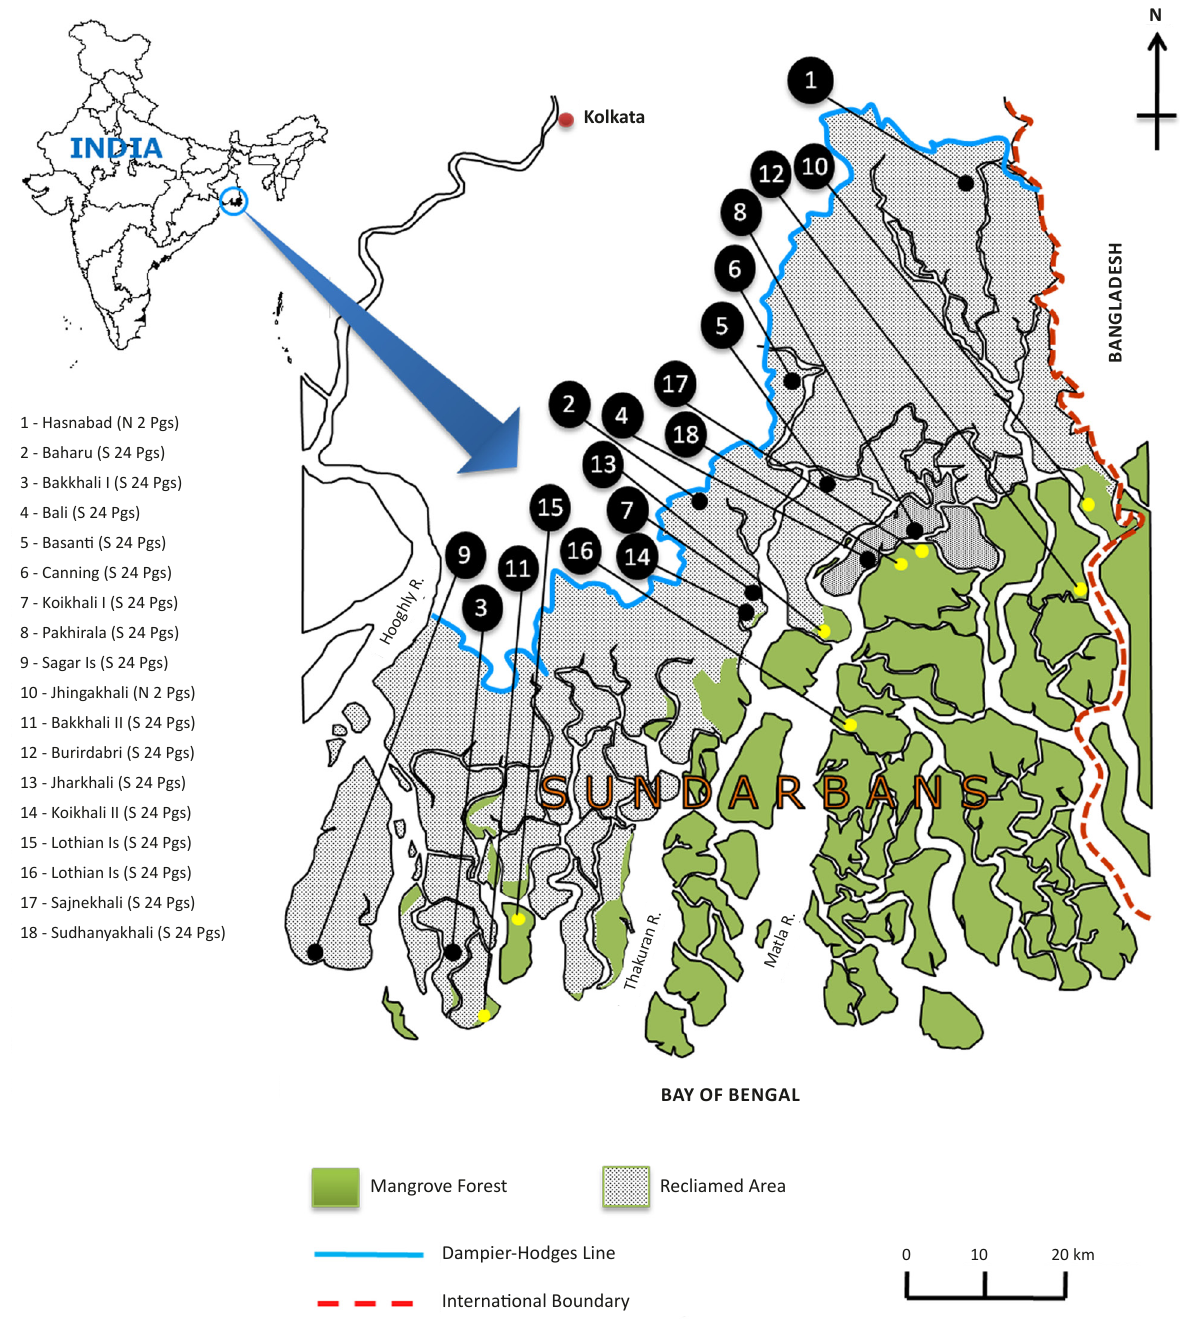
Figure 1. A map of the Indian Sundarbans delta, showing the sampling sites encompassing the North and South 24 Parganas districts of the state of West Bengal,